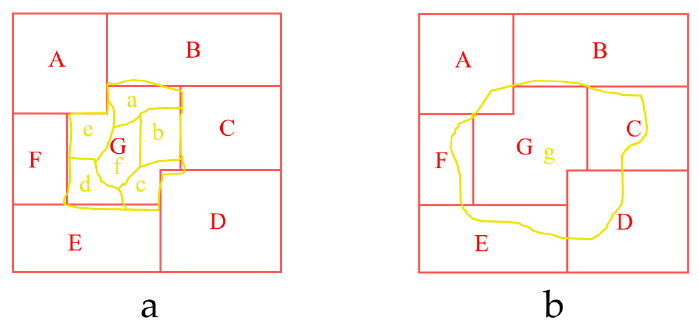
Figure 15. ( a ) Oversegmentation and ( b ) undersegmentation (red lines represent geographic objects, and yellow lines represent image objects).